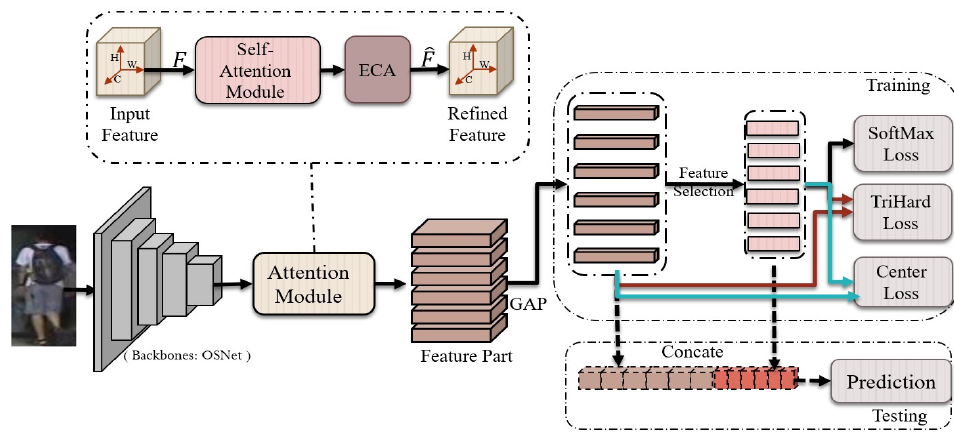
Figure 2. The architecture of the multi-part feature